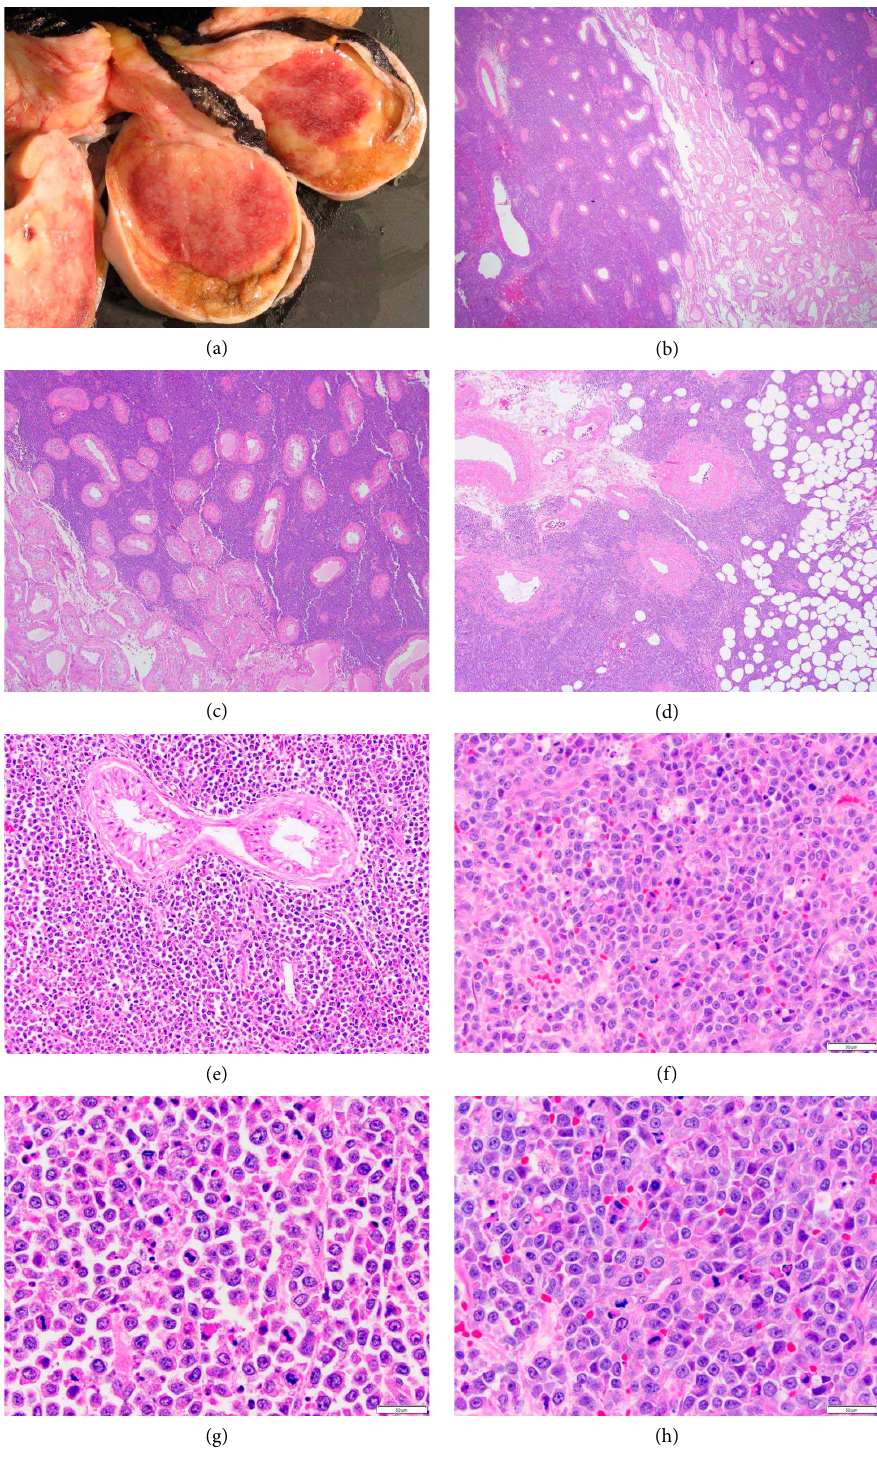
Figure 1: Gross and representative H&E images. Gross findings showed a tan-red, hemorrhagic, well-circumscribed circular mass with focal areas of tan-white friable necrosis (a). At low power, diffuse, solid sheets of densely packed neoplastic cells infiltrating the testicular parenchyma, hilar soft tissue, epididymis, and spermatic cord (b–d) with sparing of the seminiferous tubules (e) were seen. At high power (f–h), medium- sized neoplastic cells showed blastoid morphology, scant agranular cytoplasm, irregular nuclei with fine to vesicular chromatin, and small nucleoli. Increased mitotic activity with atypical mitotic figures, areas of necrosis, and abundant apoptotic debris were